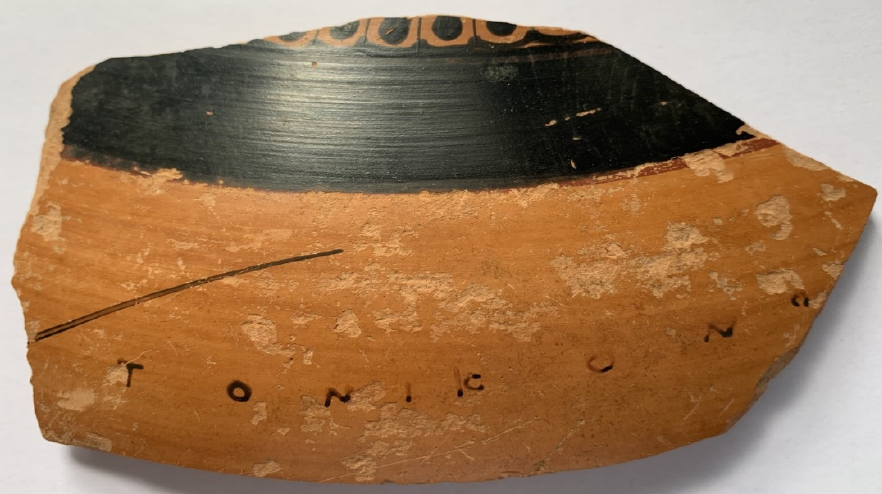
Figure 1. Inscribed fragment of a Pseudo ‐ Panathenaic Amphora, private collection.